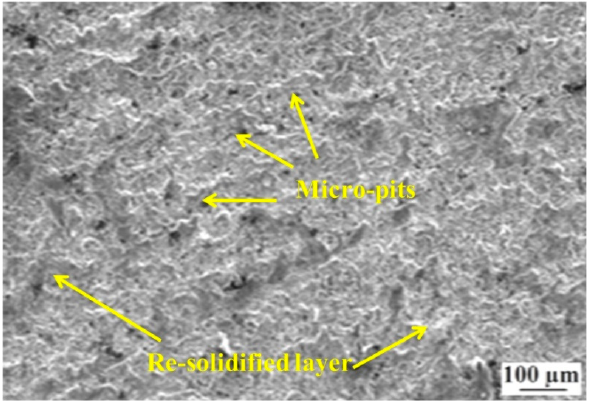
Figure 8. The machined surface corresponding to experiment number 20.